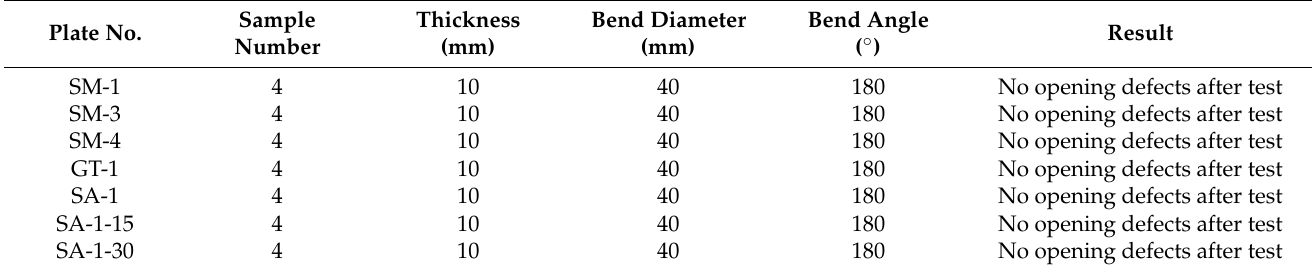
Table 9. Results of transverse side bend test.